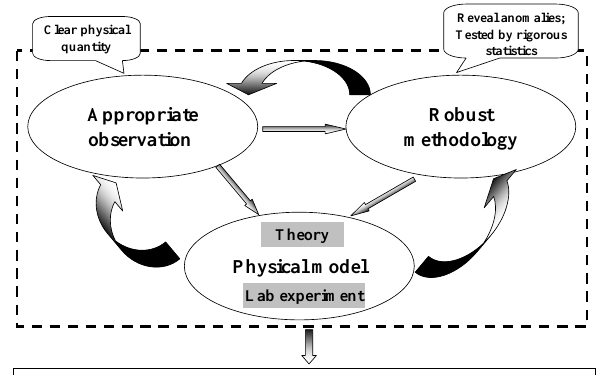
Fig. 6. An integrated research scheme towards a physics-based study on earthquake-related DC-ULF electromagnetic